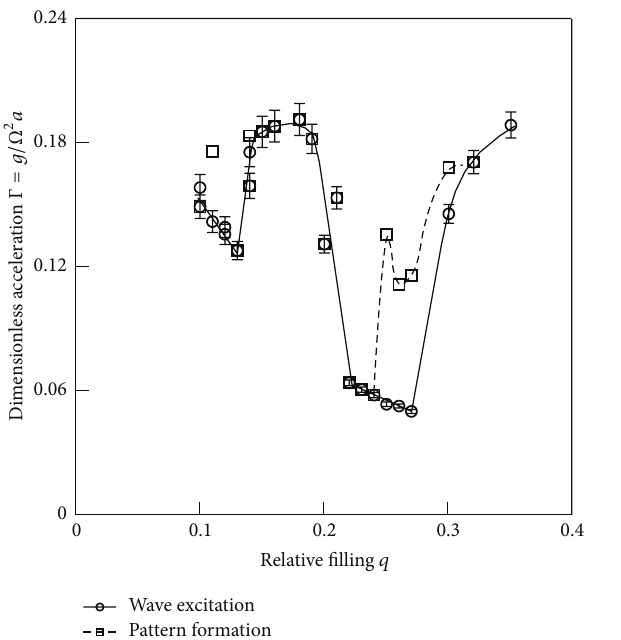
Figure 9: The thresholds of appearance of inertial waves and regular patterns; ] = 1 cSt, mass of sand 𝑚 = 125 g.